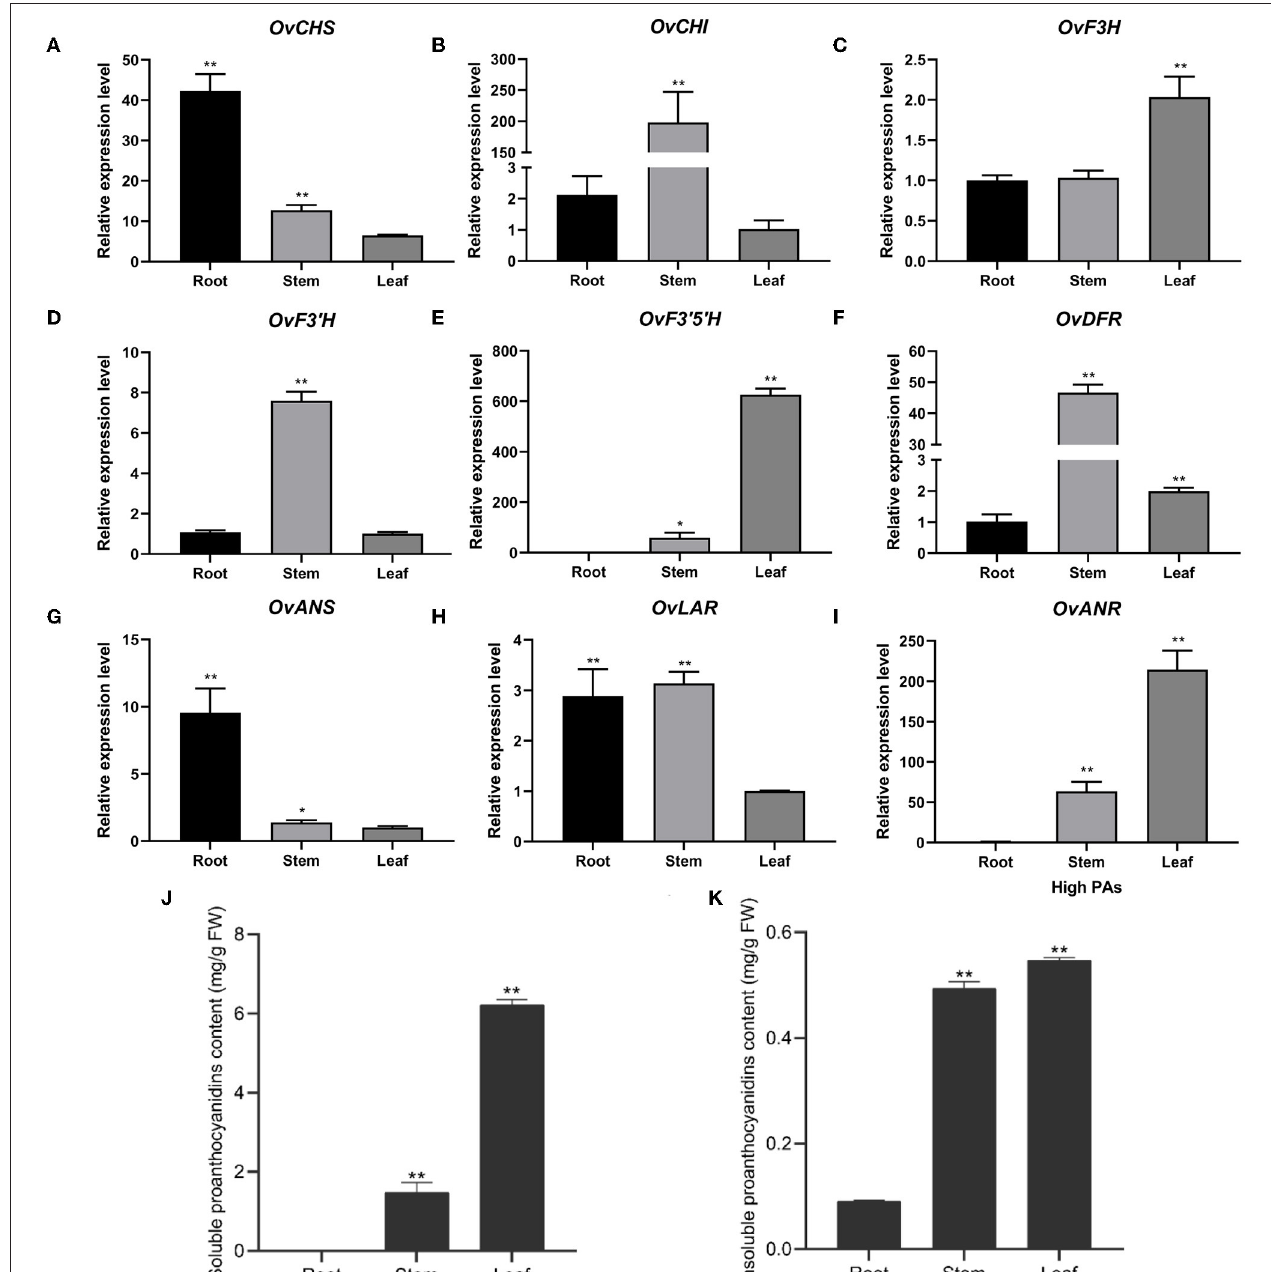
FIGURE 3 | Relative expression levels of pathway genes in different tissues of O. viciifolia. The horizontal axis is different tissues (root, stem, and leaf) of HPAs sainfoin, and the vertical axis is relative expression levels. OvCHS (A) , OvCHI (B) , OvF3H (C) , OvF3’H (D) , OvF3’5H (E) , OvDFR (F) , OvANS (G) , OvLAR (H) , and OvANR (I) . (J,K) Soluble (J) and insoluble proanthocyanidins (K) content in root, stem, and leaf of HPAs sainfoin. Error bar depicts the standard error of mean ± SD of three biological replicates. Significance of differences was represented with one asterisk ( p < 0.05) and two asterisks ( p < 0.01).